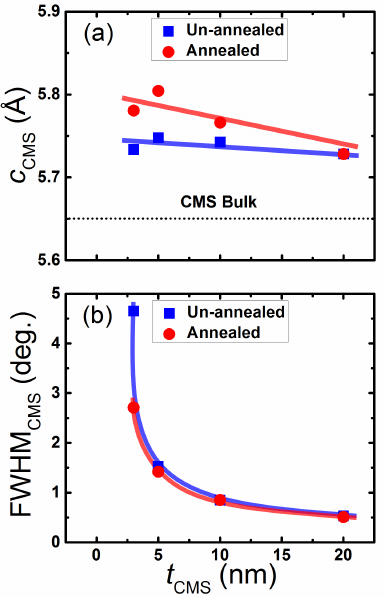
Figure 1. ( a ) X-ray diffraction (XRD) pattern of Co bilayers for the un-annealed samples; and ( b ) samples annealed at 400 ◦ C; ( c ) Expanded XRD pattern of CMS (0–20 nm)/MnGa (30 nm) bilayers for the un-annealed samples and ( d ) samples annealed at 400 ◦ C.